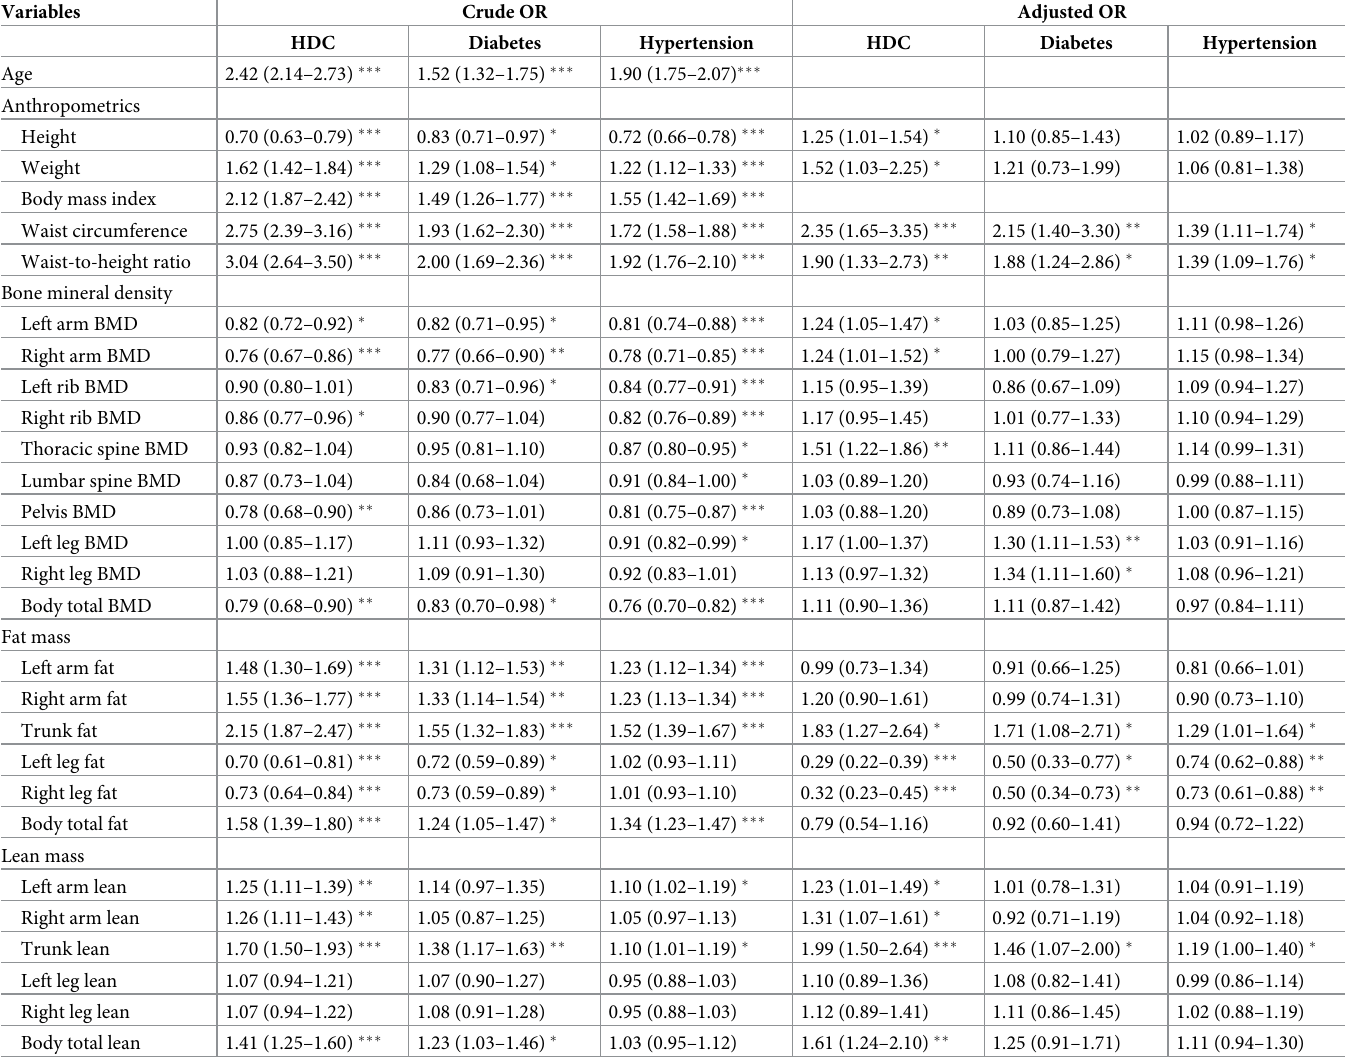
Table 3. Associations of HDC, diabetes and hypertension with anthropometrics, BMD, fat and lean mass in women.